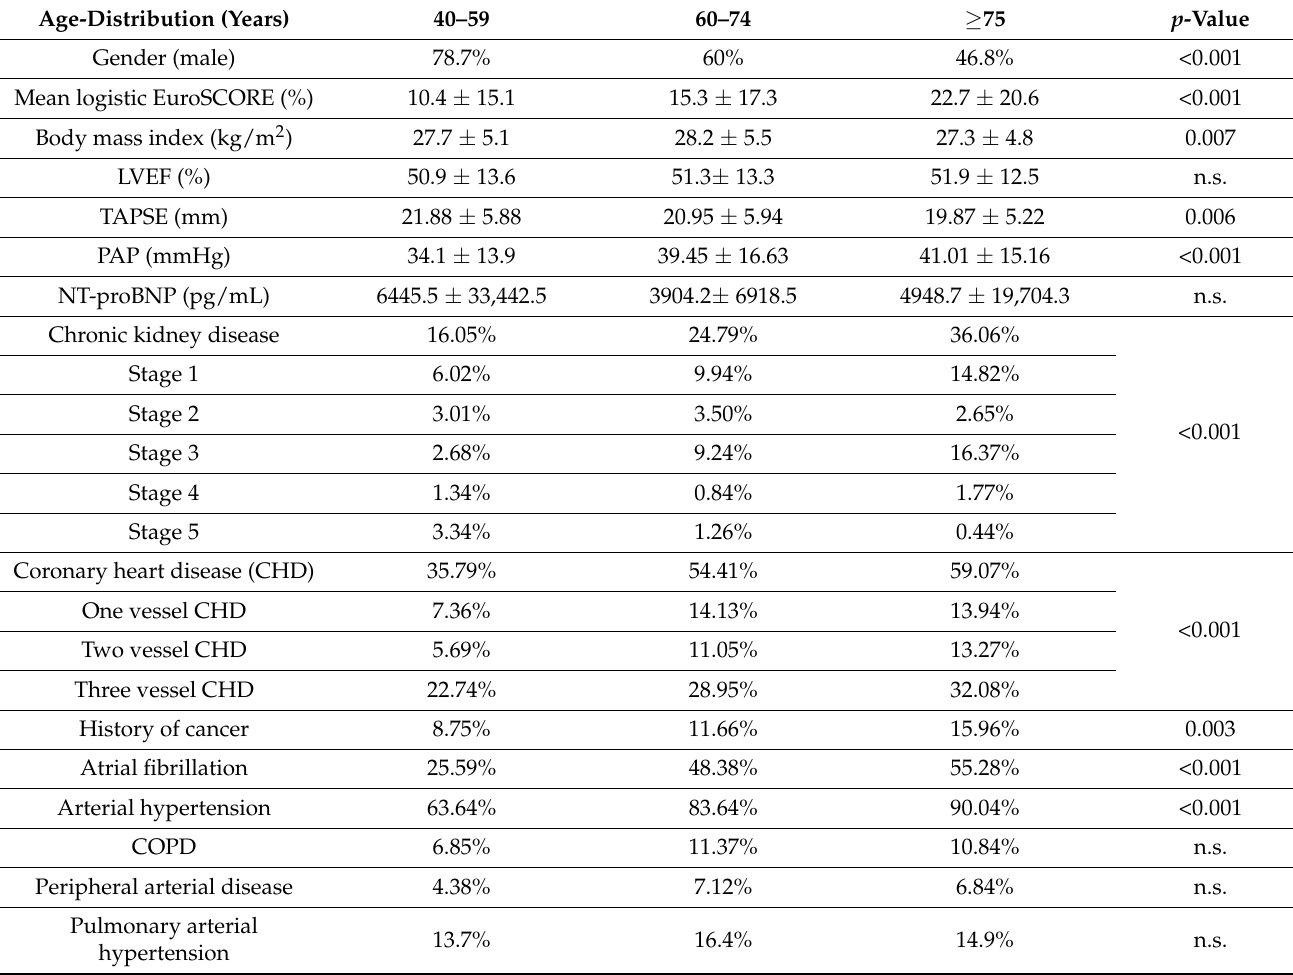
Table 1. Baseline and